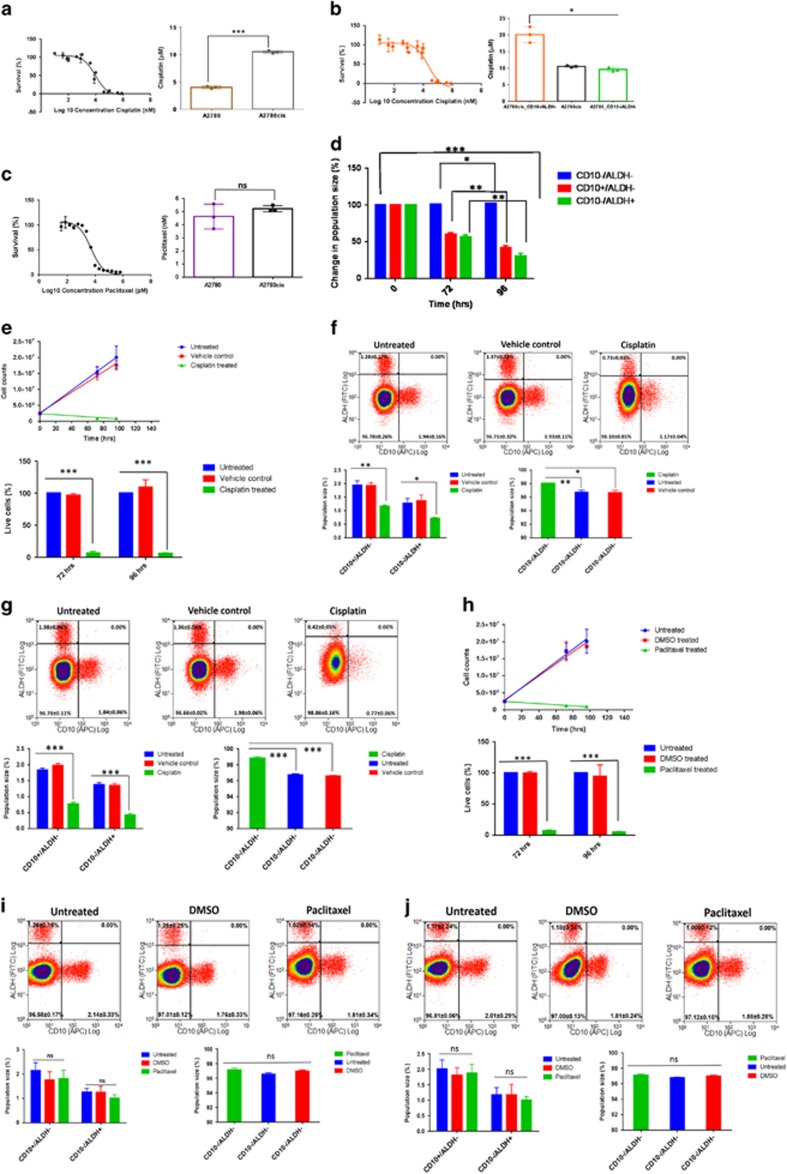
CD10−/ALDH− CSCs display adaptive cisplatin resistance and paclitaxel sensitivity. To further elucidate the relationship between the CD10/ALDH network and chemoresistance, (a) cisplatin and (b) paclitaxel IC50s were established. A2780cis cells were found to be more resistant to cisplatin than A2780 cells (a: A2780cis IC50=11±0.4 μM; n=3). A cisplatin dose–response curve indicated that this appears to be due to acquired cisplatin resistance of CD10−/ALDH− CSCs (b: IC50=20.1±0.4 μM; n=3). In contrast, A2780 and A2780cis cells were found to be similarly sensitive to paclitaxel (c: A2780cis IC50=5.2±0.2 μM). A2780cis cells were treated with cisplatin for 72 (e and f) and 96 (e and g) hours. Although untreated and DMSO vehicle-treated control cells were unaffected, cisplatin treatment resulted in a proportional increase in the CD10−/ALDH− population, as the other populations showed substantial cell death (d–g). (h–i) Seventy-two and (h and j) 96 h 4.6 nM paclitaxel treatment resulted in substantial cell death (h), which affected all three populations uniformly (h–j). All data were confirmed by statistical analysis (bar charts, unpaired Student’s t-test, mean population size (%)±S.D. of n=3, NS=not significant, ***P-value<0.0001). Together, these data indicate that CD10−/ALDH− CSCs possess inherent and acquired cisplatin-resistance mechanisms. Again, the entire ovCSC network is highly sensitive to paclitaxel